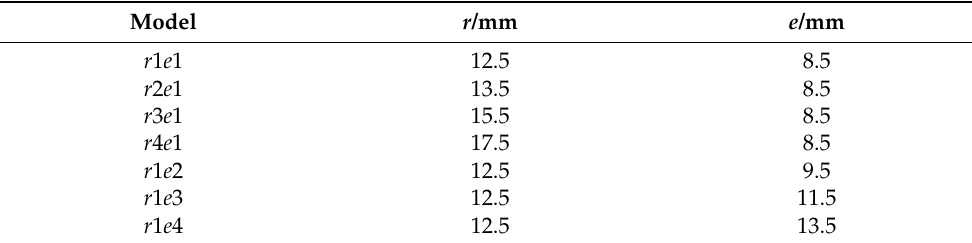
Table 1. Value of models with different cooling flow path structure parameters.